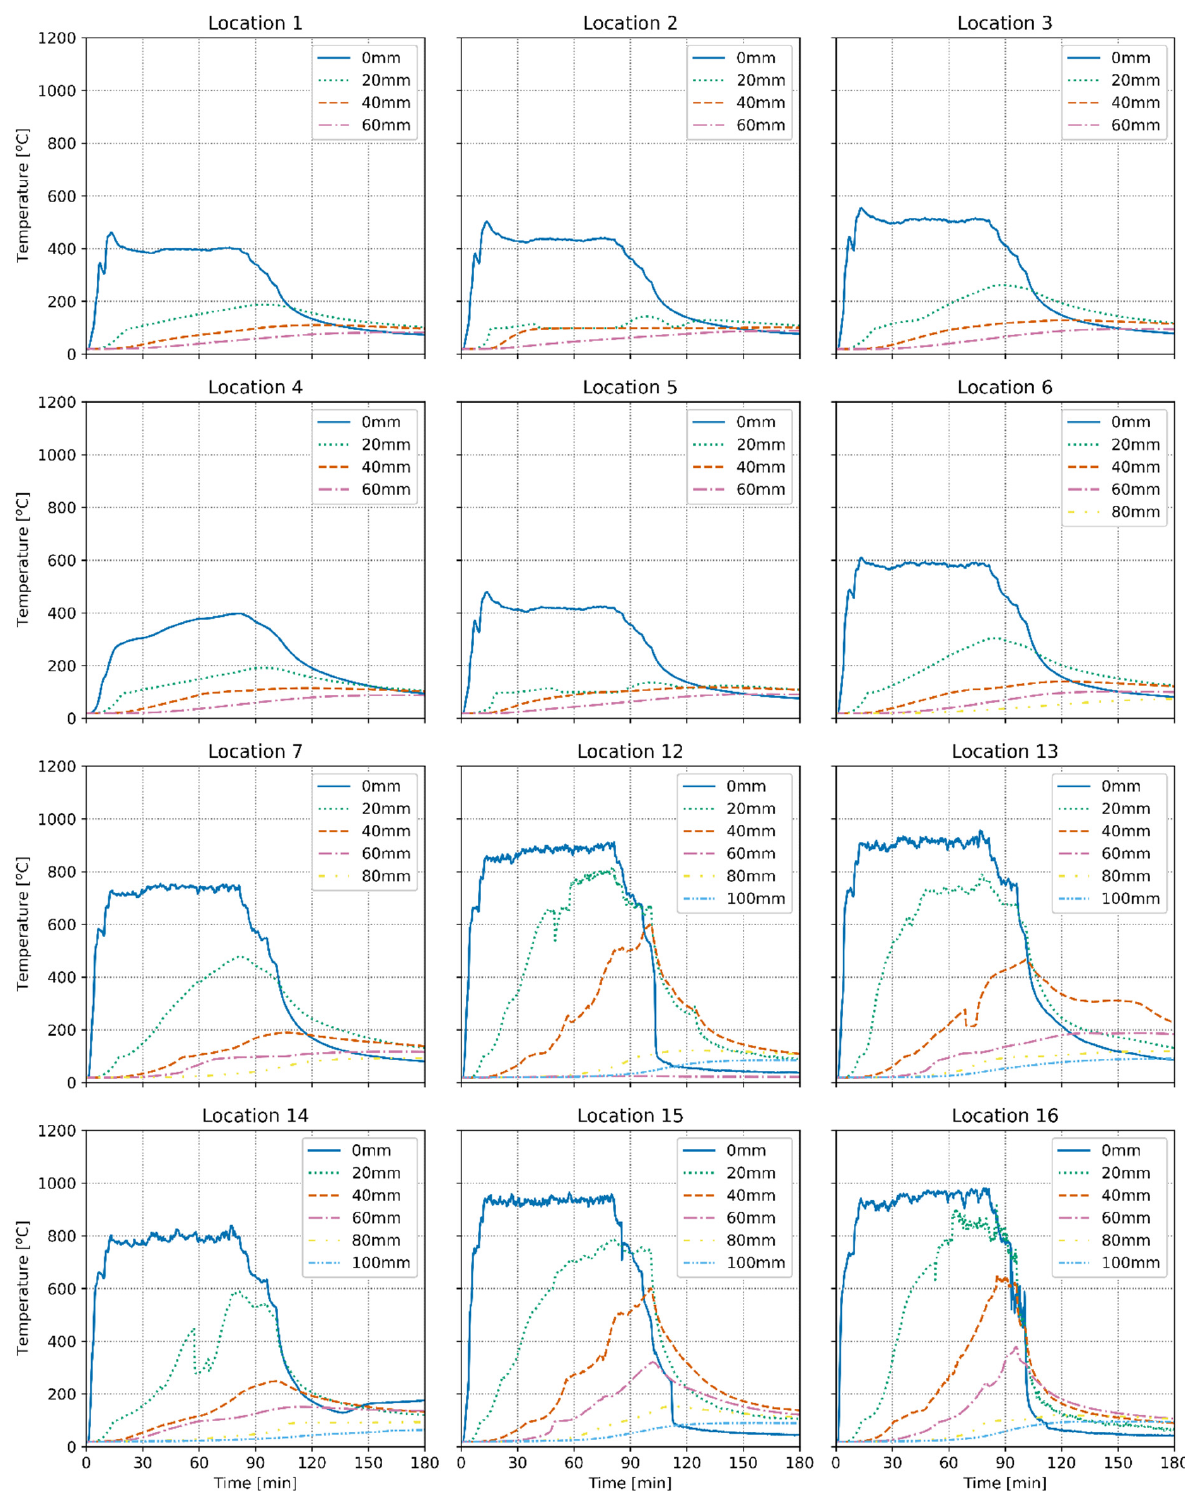
Figure 12. Surface and in-depth temperatures for Experiment 3.